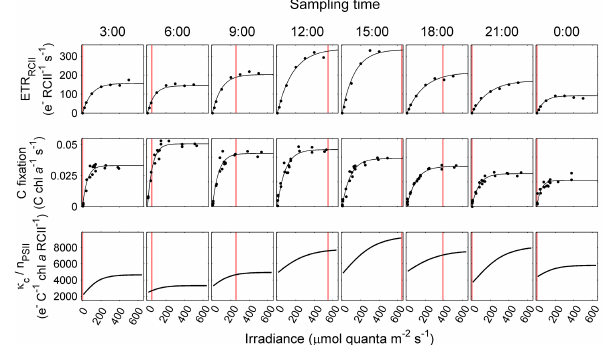
Figure 1. Diurnal variation in rates and light dependency of ETR RCII , carbon fixation, and the derived conversion factor K c /n PSII . P vs. E curves of ETR RCII (mole − molRCII − 1 s − 1 ) and carbon fixation (molCmolchl a − 1 s − 1 ) were measured at 3h intervals over a 24h diurnal cycle. Data were fit to the exponen- tial model of Webb et al. (1974). The conversion factor K c /n PSII (mole − molC − 1 molchl a molRCII − 1 ) and its light dependency were derived as the quotient of corresponding values of ETR RCII and carbon fixation. The vertical line on plots corresponds to in situ PAR values at 5m depth during sampling for each time point.